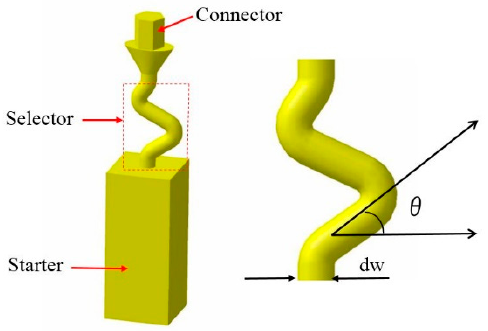
Figure 1. Schematic illustrations of the new 2-D grain selector and the corresponding grain selector portion.